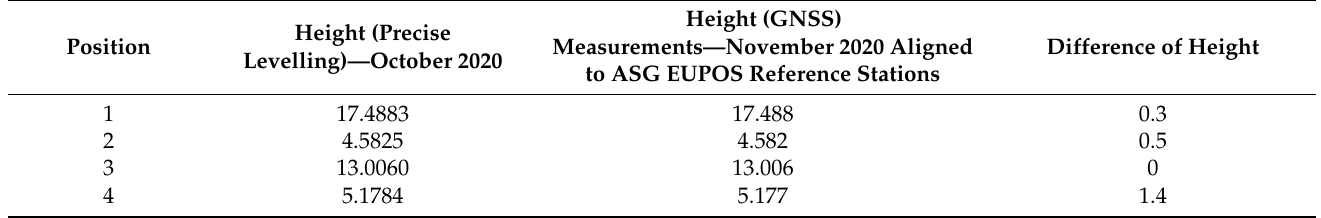
Table 2. The height of benchmarks in stable positions and in position near the EcoGenerator, from precise levelling and GNSS-GPS